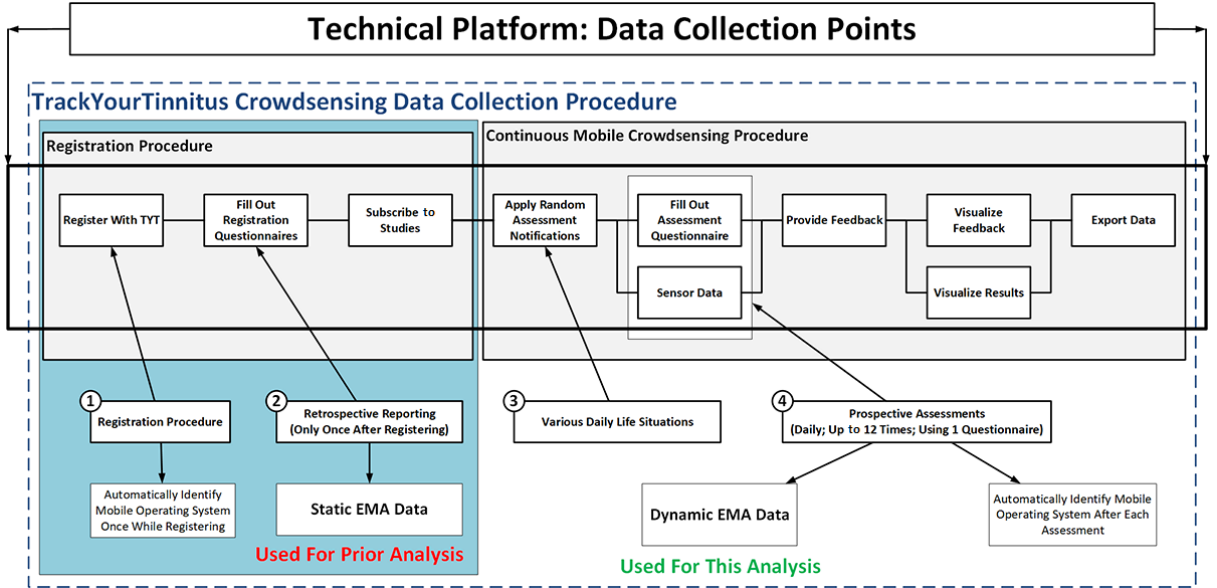
Figure 1. TrackYourTinnitus (TYT) mobile crowdsensing collection procedure. EMA: ecological momentary